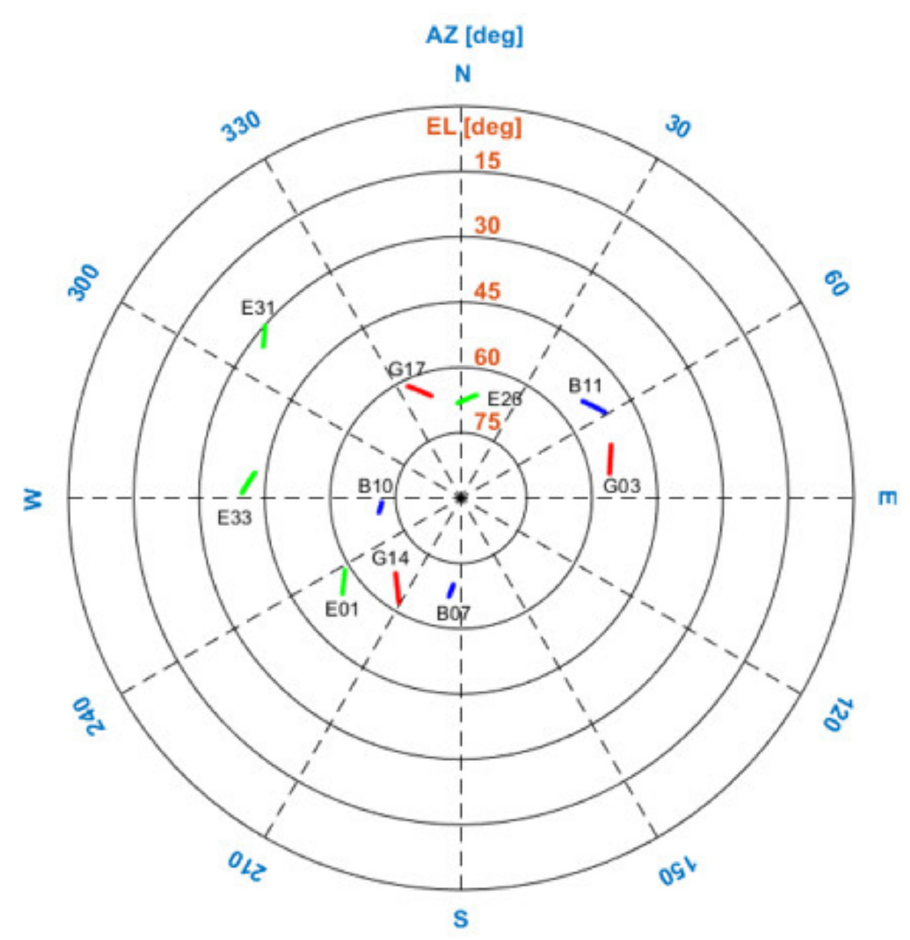
Figure 17. Satellites commonly in view in the two cells during the flight test. GPS, Beidou, and Galileo satellites are indicated by the red, blue, and green lines,